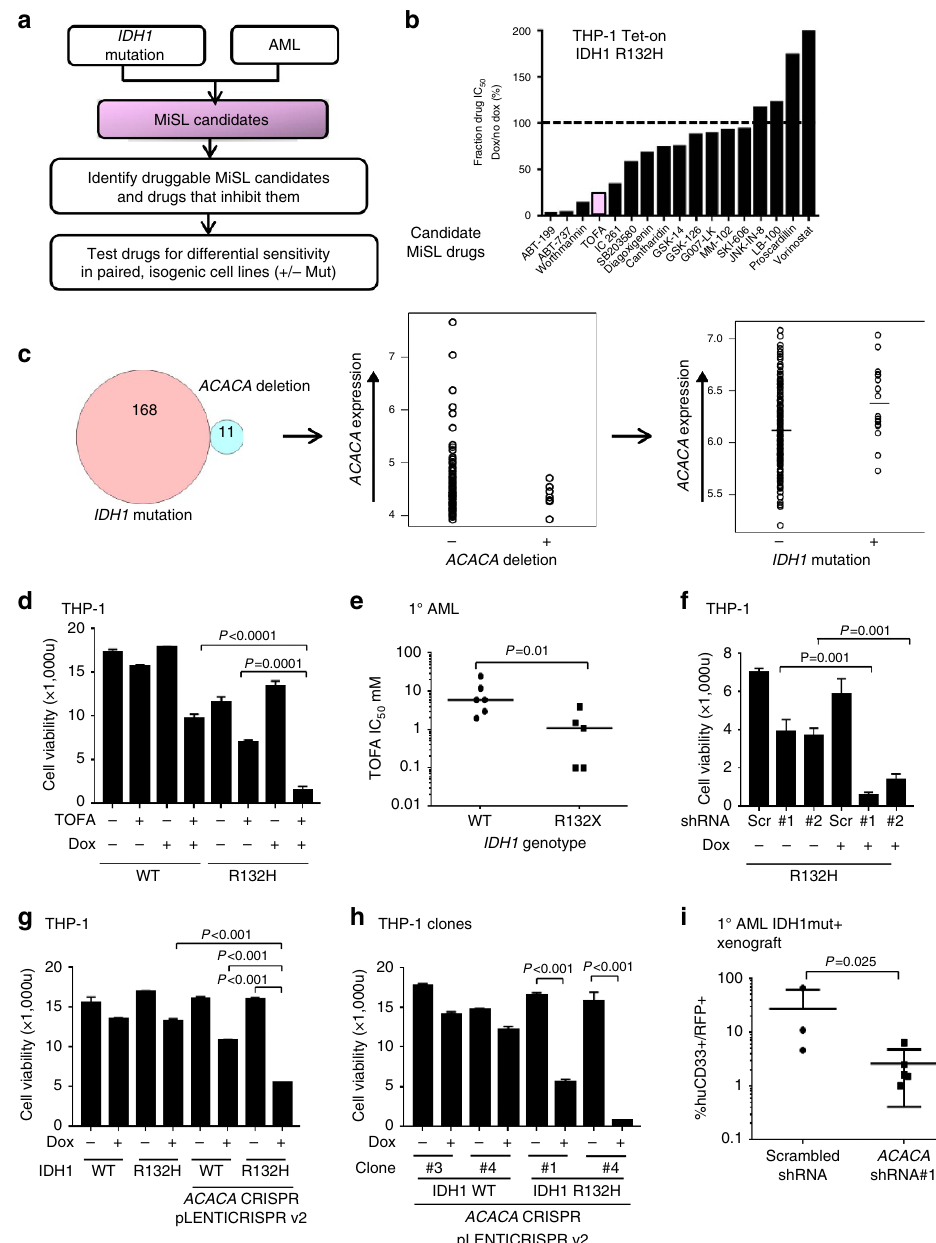
Figure 3 | MiSL identifies a novel therapeutic target for the IDH1 mutation in acute myeloid leukaemia. ( a ) Schematic for testing druggable targets for IDH1 R132H mutation in AML. MiSL candidates were filtered for druggability using the DGIdb database. Seventeen compounds were obtained that were predicted to antagonize/inhibit the products of these genes, which were tested for synthetic lethality with IDH1 R132H. ( b ) Seventeen drugs were tested in the absence ( (cid:2) Dox) or presence ( þ Dox) of IDH1 R132H mutation and IC 50 s were calculated based on cell viability after 72h. ( c ) MiSL found (i) mutual exclusion of IDH1 mutation and ACACA gene deletion, (ii) ACACA deletion causes low expression ( P ¼ 0.001) and (iii) expression of ACACA is higher in IDH1 -mutated AML ( P ¼ 0.008). ( d ) Viable cell growth (PrestoBlue fluorescence) of THP-1 cells at 10 days expressing IDH1 wild type ( (cid:2) Dox) or R132H mutant ( þ Dox) plated in 2 m M TOFA or DMSO in 0.5% serum, bars show s.d., P value ¼ 0.0001. ( e ) Purified primary IDH1 mutant and IDH1 wild-type AML blasts plated in increasing concentrations of TOFA. Sigmoidal dose–response IC 50 s were calculated and compared with Mann–Whitney U , P value ¼ 0.01. ( f ) Viable cell growth of THP-1 cells expressing IDH1 wild type ( (cid:2) Dox) or R132H mutant ( þ Dox) transduced with scrambled or ACACA shRNA lentivirus in 0.5% serum as in d . ( g ) Viable cell growth of THP-1-inducible IDH1 wild-type or R132H ( þ / (cid:2) Dox) cells transduced with lentiviral pLENTICRISPR v2 targeting ACACA exon 4 versus non- ACACA targeted controls. ( h ) Growth of single clones from the same pLENTICRISPR v2 transduced THP-1 cells as in g . ( i ) Primary IDH1 R132 mutant AML blasts were transduced with ACACA shRNA #1 or scrambled shRNA and transplanted into immunodeficient NSG mice. Bone marrow at 12 weeks was analysed for human CD45 þ CD33 þ RFP þ cells. Scatter plot shows absolute and average percentage of hCD33 þ RFP þ cells gated on human CD45 þ engrafted cells ( n ¼ 3, non-targeting versus n ¼ 5, shRNA#1, * P o 0.05, Mann–Whitney). Panels d and f – h show representative of three independent experiments using four biological replicates; Student’s t -test is used to calculate significance with P values as